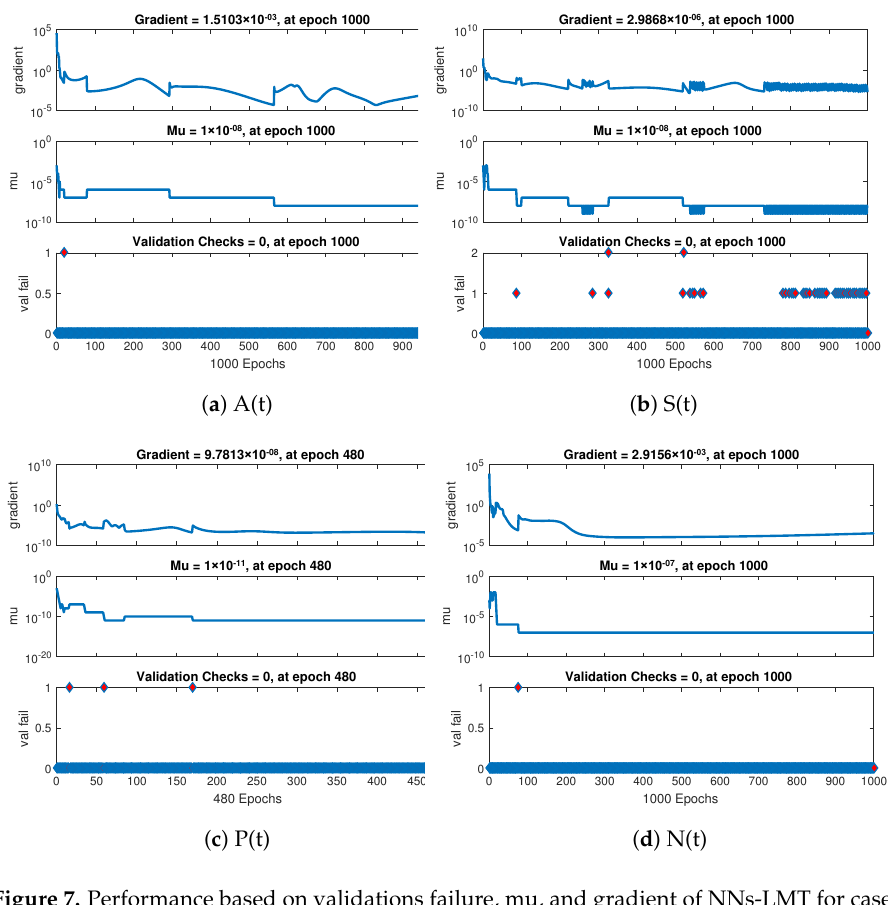
Figure 7. Performance based on validations failure, mu, and gradient of NNs-LMT for case 1.